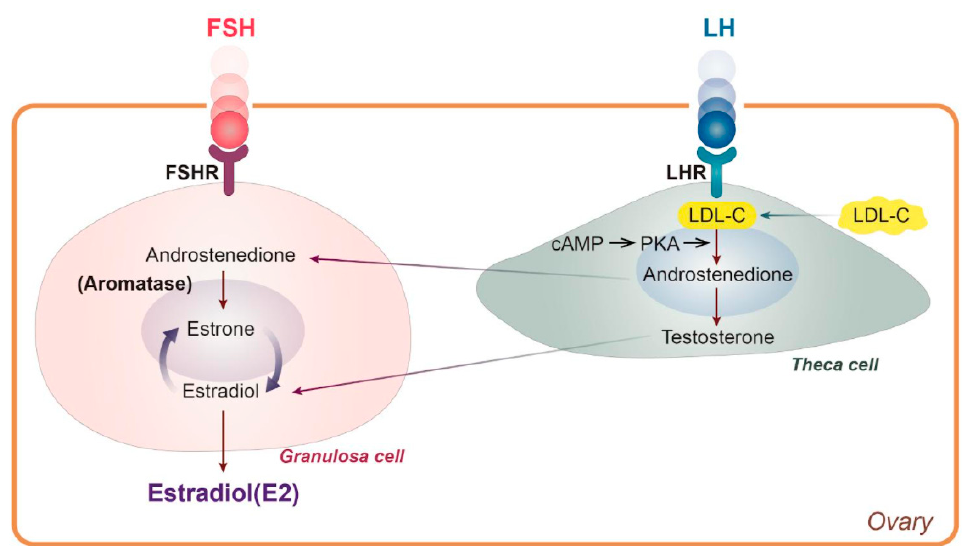
Figure 1. LDL cholesterol is used for E2 synthesis. cAMP: cyclic adenosine monophosphate, E2: estradiol, FSH: follicle-stimulating hormone, FSHR: follicle-stimulating hormone receptor, LDL-C: low-density lipoprotein cholesterol, LH: luteinizing hormone, LHR: luteinizing hormone receptor, PKA, protein kinase A.